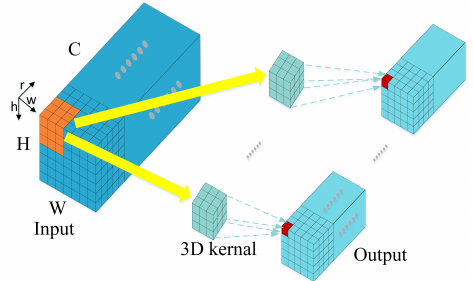
Figure 1. The process of 3D